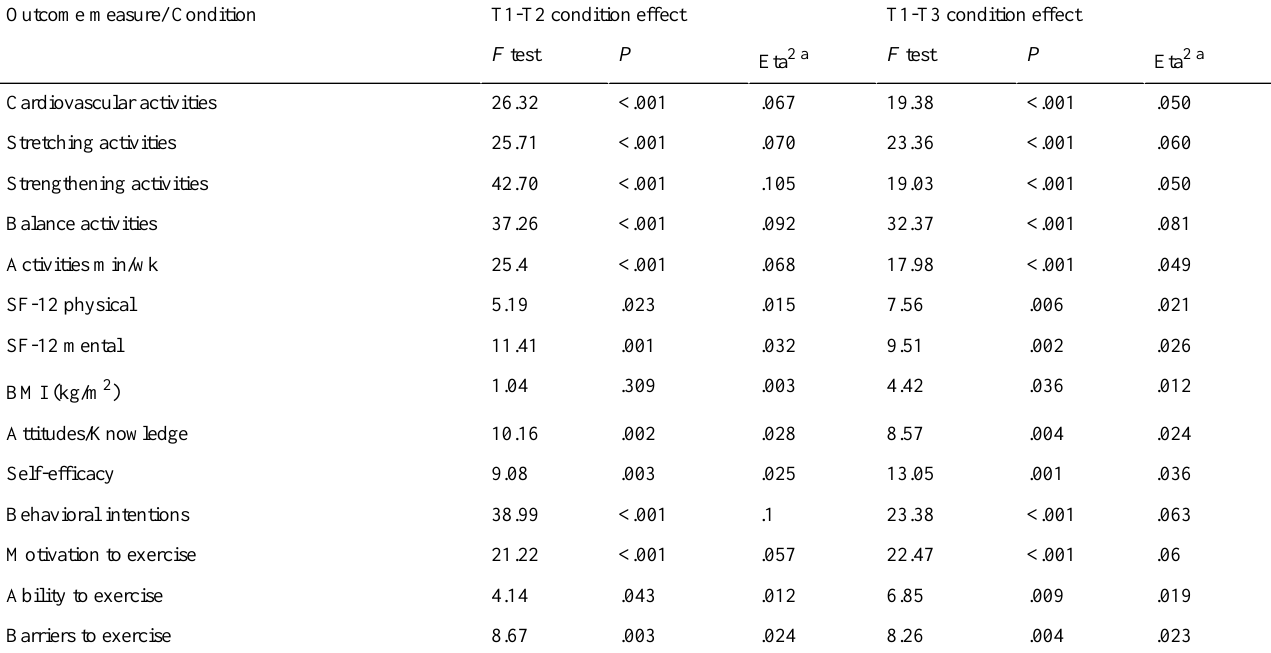
Table 1. ANCOVA results for the outcome